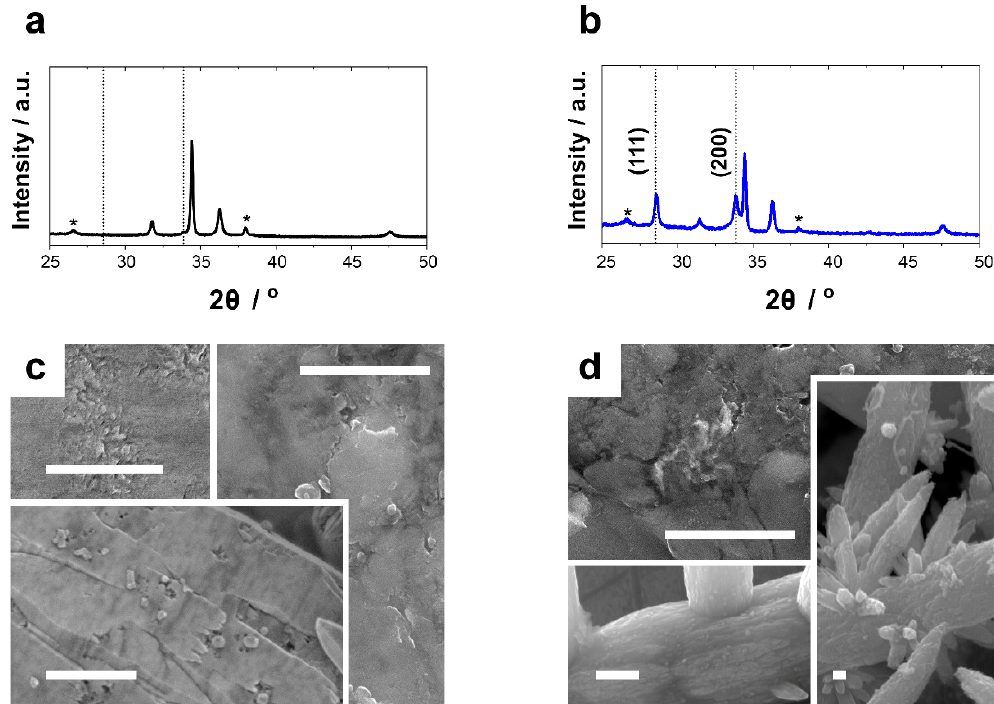
Figure 2. XRD patterns of ( a ) ZnO and ( b ) ZnO@ZnS(4 h) micro/nanoferns. Diffraction peaks corresponding to the ZnS blende and fluorine-doped tin oxide substrate structures are indicated with a dashed line and *, respectively. FE-SEM micrographs of ( c ) ZnO and ( d ) ZnO@ZnS(4 h) micro/nanoferns. Scale bar: 200 nm.